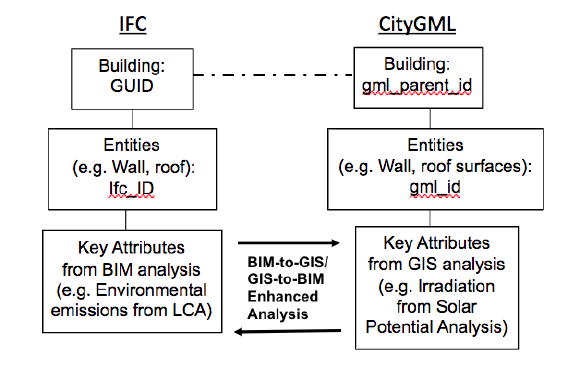
Figure 6. Exemplary principle of manual transferal of key attributes for cross-domain